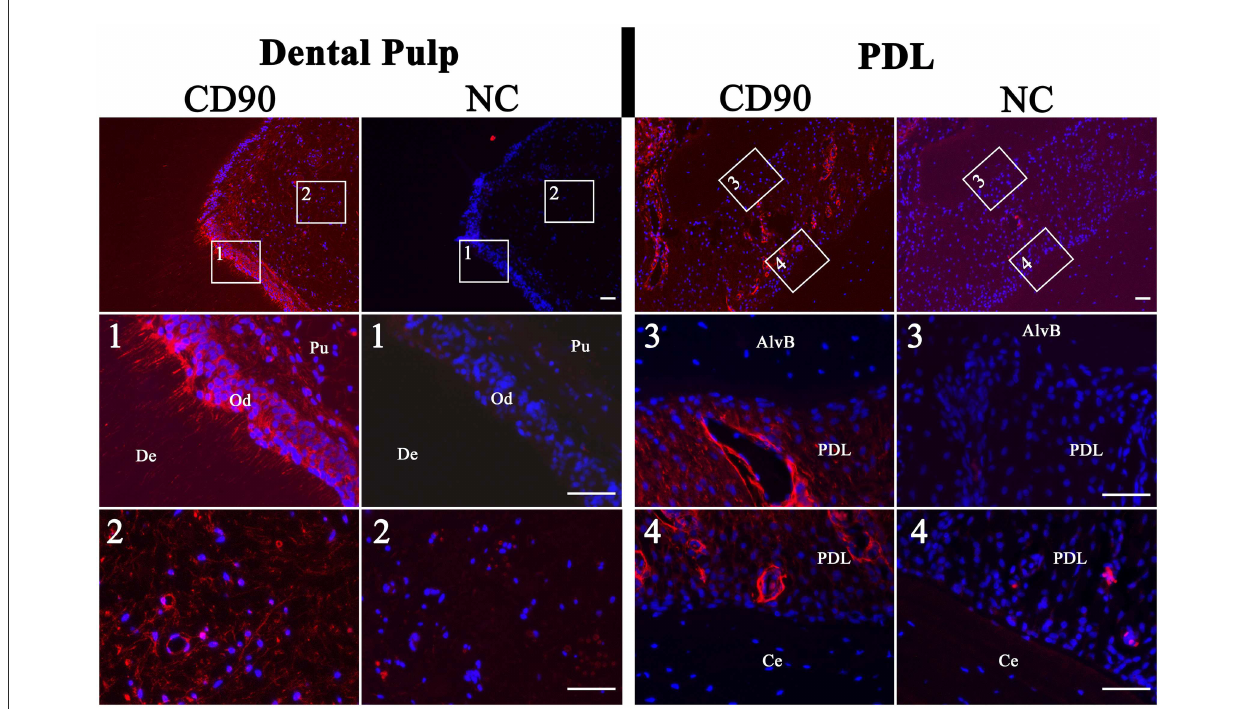
FIGURE9 Immunohistochemistry of dental pulp and PDL for CD90 (red). The nuclei were stained with DAPI (blue). Associated negative controls (NC) are pictured besides the samples. The dental pulp showed a high-intensity signal of the odontoblastic layer (Od). Even inside the longitudinally broached dentine tubuli (De) and within the dental pulp (Pu) a signal was detected. The PDL showed a diffuse signal and a more intense perivascular signal. Cells inside the alveolar bone (AlvB) and cementum (Ce) were negative. Scale bar represents 50 µ